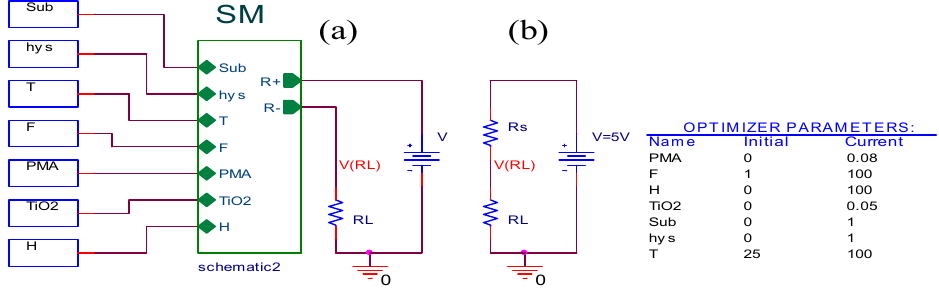
Figure 4. (a) The humidity sensor electrical circuit (b) The measurement circuit of the sensor